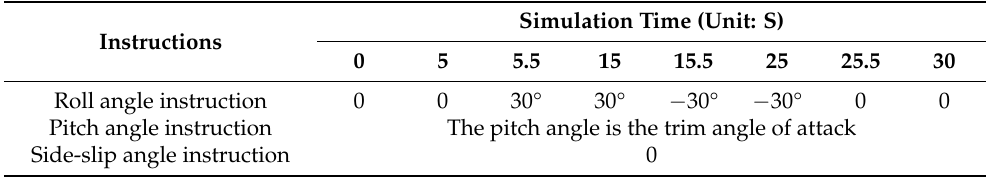
Table 4. Input instructions for roll maneuver.